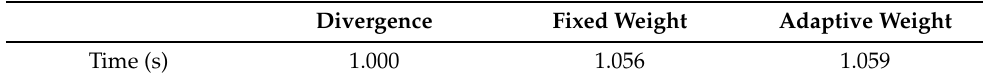
Table 11. Computational burden of the three algorithms in